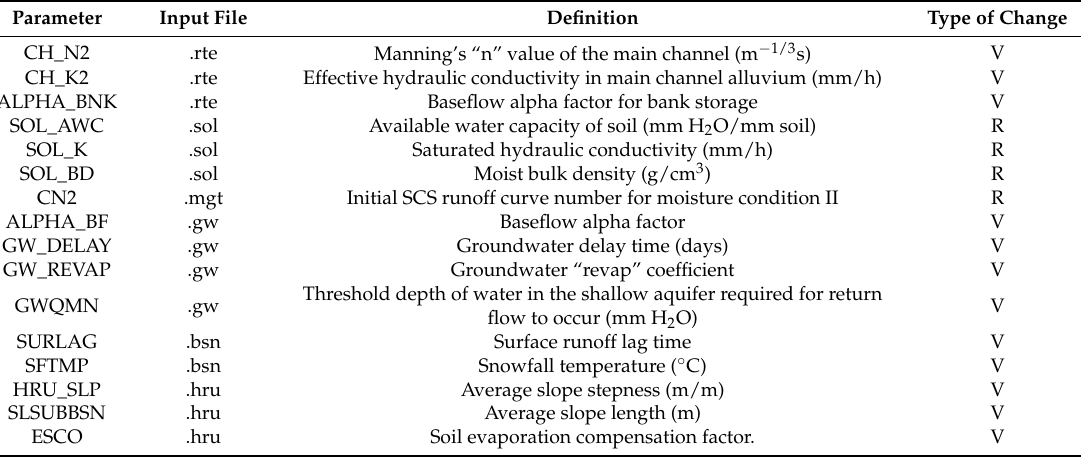
Table 2. Parameters for daily and sub-daily SWAT models. “V” means the existing parameter will be replaced by a given value; “R” means that the existing parameter is multiplied by (1 ± a given